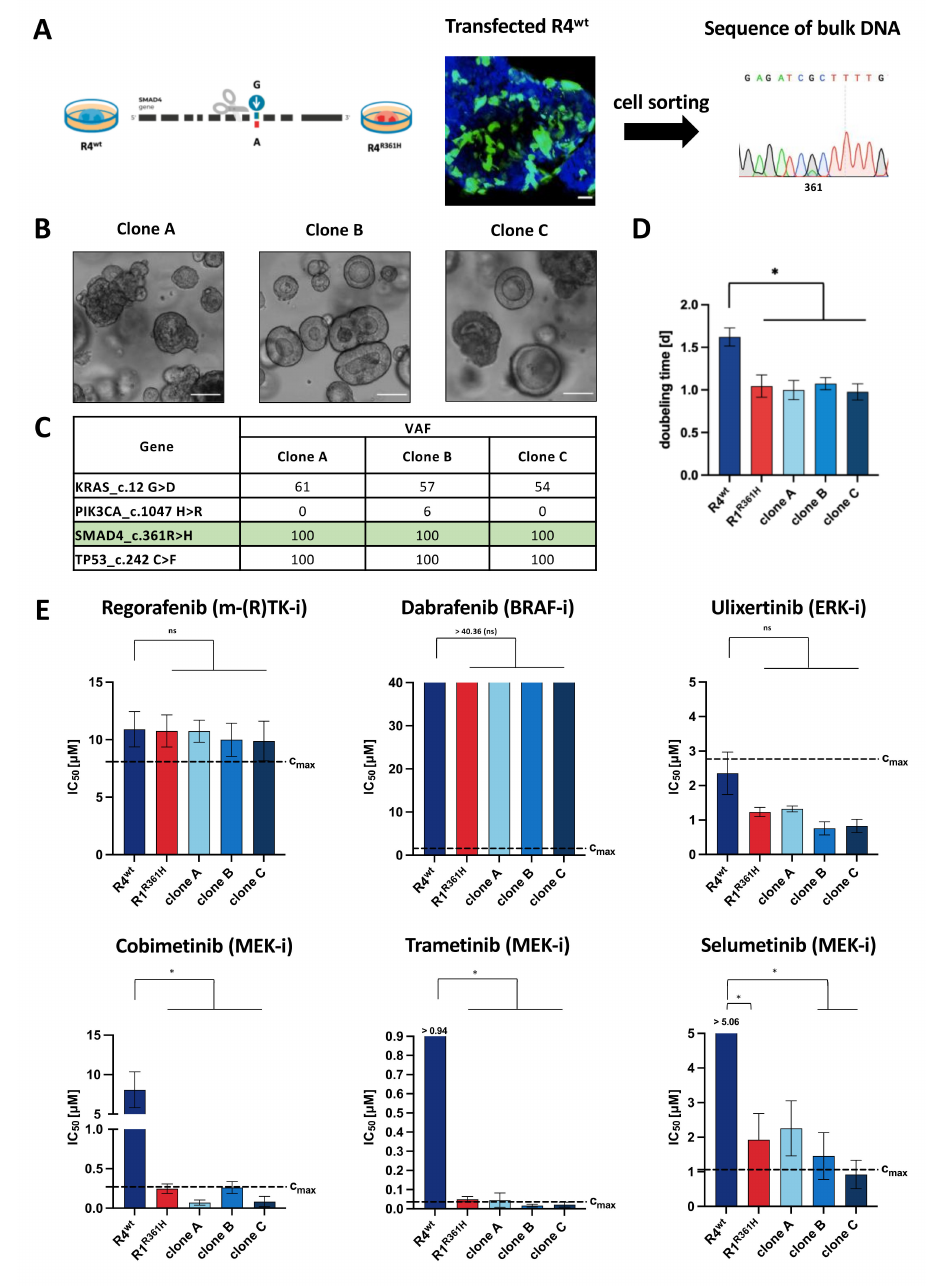
Figure 2. SMAD4 R361H influences sensitivity to MEK inhibition. ( A ) Generation of CRISPR- engineered PDOs: transfected R4 wt ( SMAD4 wt ) PDOs were sorted and sequenced as a bulk pop- ulation. ( B ) Representative images of three single clones (clones A, B, and C) that were expanded for further analysis. ( C ) DNA-panel-sequencing confirmed homozygote SMAD4 R361H mutation in each CRISPR- SMAD4 R361H clone (clones A, B, and C). ( D ) Doubling times of R4 wt , R1 R361H , and CRISPR- SMAD4 R361H PDOs (clones A, B, and C). The cell density was measured on day 2, 3, 5, and 7 by measuring cellular ATP content using Cell Titer Glo ® assay. Results from four independent experiments were combined (one-way ANOVA * p < 0.05). ( E ) IC 50 values of R4 wt and R1 R361H and CRISPR- SMAD4 R361H PDOs (clones A, B, and C each in biological triplicates) treated daily for 4 days with small molecules targeting the MAPK signaling pathway. Achievable maximal plasma concentrations (c max ) are indicated for each drug with dotted lines. In all panels: ns = not significant; * p < 0.05, values as mean ± SEM using one-way ANOVA and Tukey’s test for multiple comparisons. (Scale bars = 100 µ m (A and B)). (See also Figure